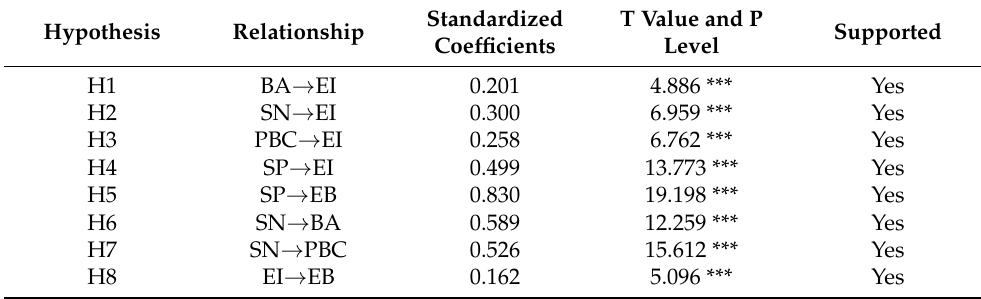
Table 6. Structural equation model estimation results (direct effects) and hypotheses